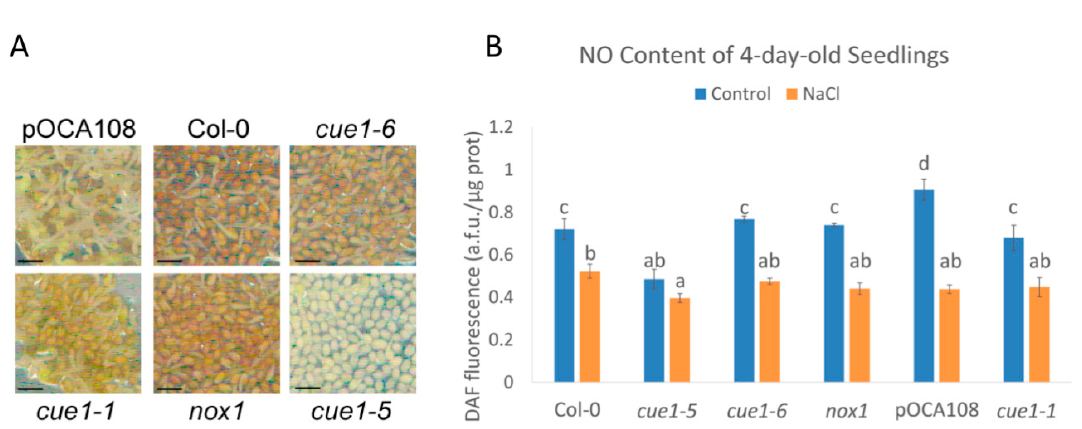
Figure 1. Phenotype ( A ) and nitric oxide (NO) content ( B ) of 4-day-old seedlings. Scale bar, 1 mm. DAF fluorescence intensity of extracts of 4-day-old seedlings grown on Murashige and Skoog (MS) with and without 100 mM NaCl. Values represent the mean ± CI ( n = 3). Bars with common letters (a–d) do not show significant statistical di ff erences. A two-way analysis of variance (ANOVA) with post-hoc Tukey’s honestly significance di ff erence (HSD) test showed a statistically significant interaction between genotype and salinity ((F (5,24) = 23.13, p < 0.001, eta2[g] = 0.83). An analysis of simple main e ff ects for each factor was performed with statistical significance after a Bonferroni correction (Table S2).